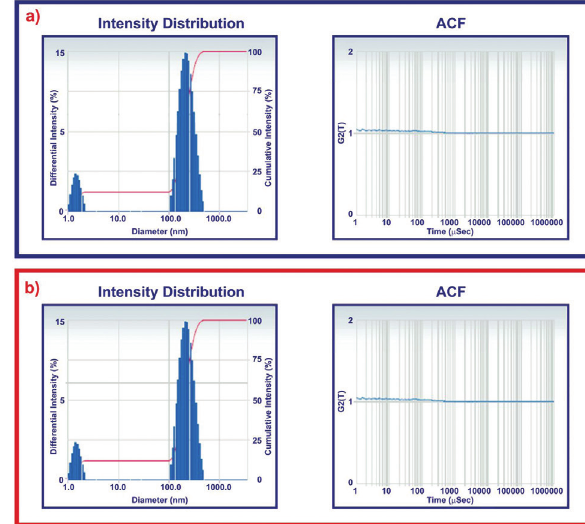
Figure 10: DLS analysis of synthesized silver nanoparticle obtained from: (a) Averrhoa bilimbi leaf extract, (b) Plum fruit